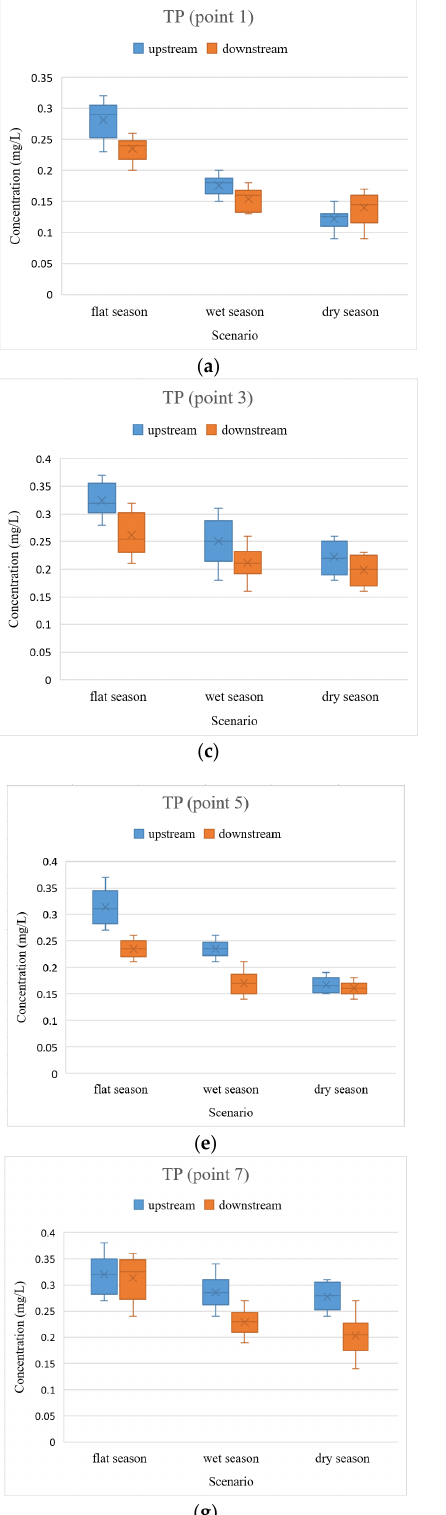
Figure 2. Comparison of TN upstream and downstream of the rivers in the closed state of the sluices. ( a ) TN concentrations at point 1; ( b ) TN concentrations at point 2; ( c ) TN concentrations at point 3;